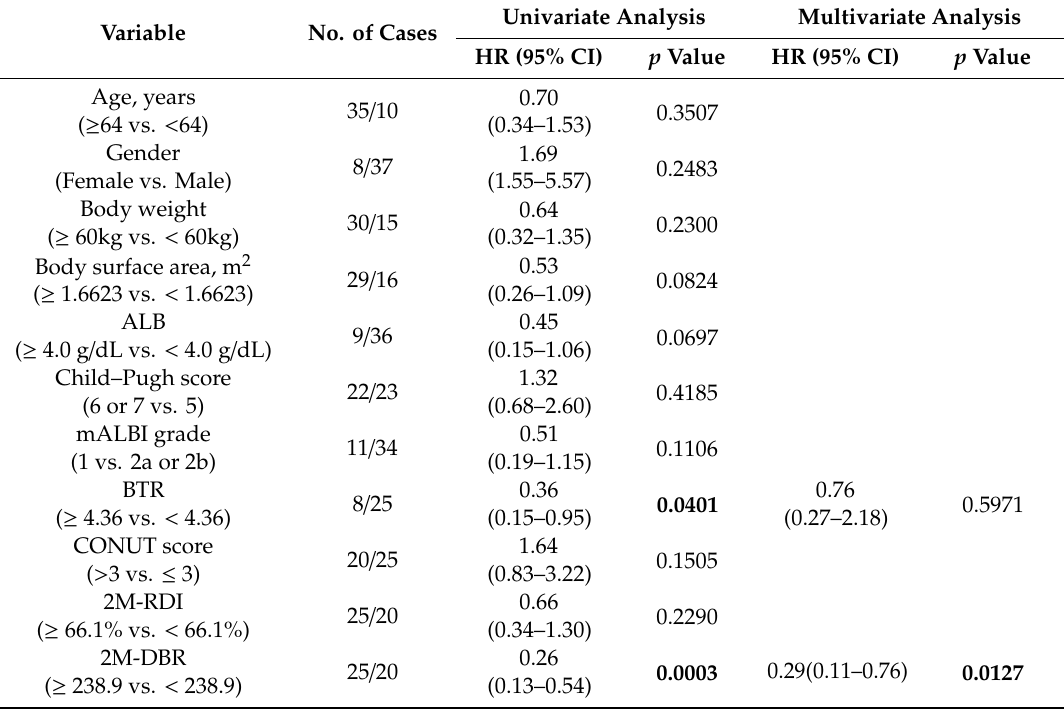
Table 6. Comparison between patients with high 2M-DBR and low